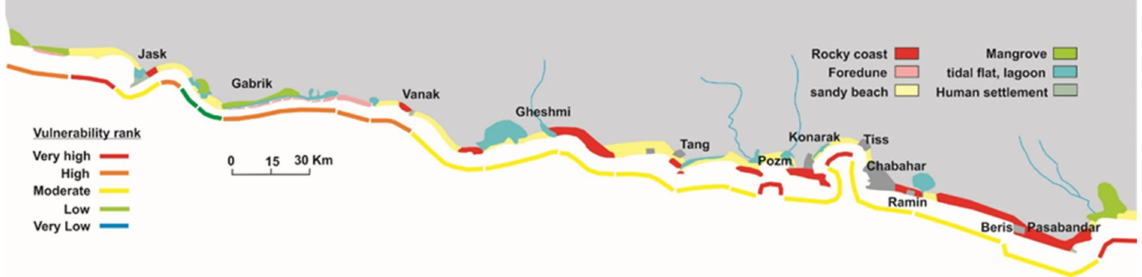
Figure 5. Risk rating of the Iranian coast of Makran based on coastal elevation.